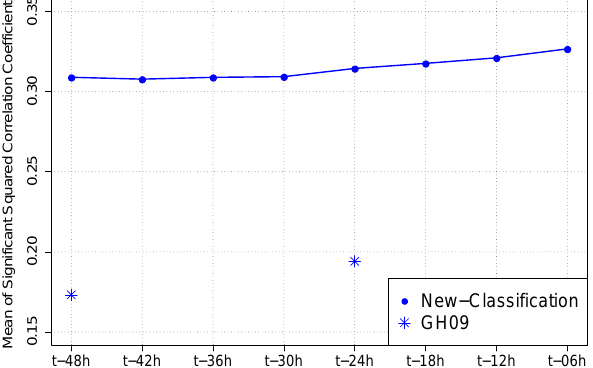
Fig. 3. Time serie of the mean of the significant squared correlation coefficients obtained for all variables and levels considered in this study and its equivalent obtained by GH09.